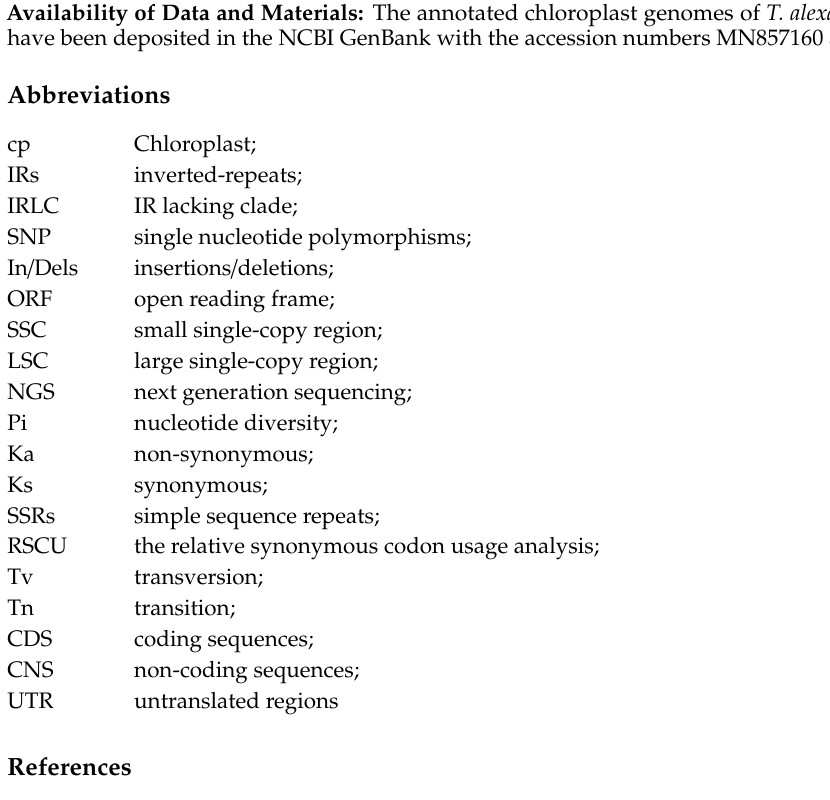
Figure S1. The relative synonymous codon usage (RSCU) for the T. alexandrinum and T. resupinatum . Figure S2. The assembly sequence genomic coverage maps of T. alexandrinum and T. resupinatum. Table S1. Location and length of intron-containing genes in the chloroplast genomes of T. alexandrinum and T. resupinatum . Table S2. The shared repeats of T. alexandrinum and T. resupinatum . * means the shared location for T. alexandrinum and T. resupinatum , res means locations particular for T. resupinatum , the numbers of “Number” mean number of repeats in T. alexandrinum and T. resupinatum , respectively. Table S3. The relative synonymous codon usage (RSCU) analyzed using CodonW. Table S4. Transversion (Tv) and transition (Tn) were detected between T. alexandrinum and T. resupinatum . Table S5. The synonymous / synonymous substitution rates (Ka / Ks) calculated using 59 shared genes in T. alexandrinum and T. resupinatum . Table S6. The nucleotide diversity (Pi) computed using 96 common genes of T. alexandrinum and T. resupinatum